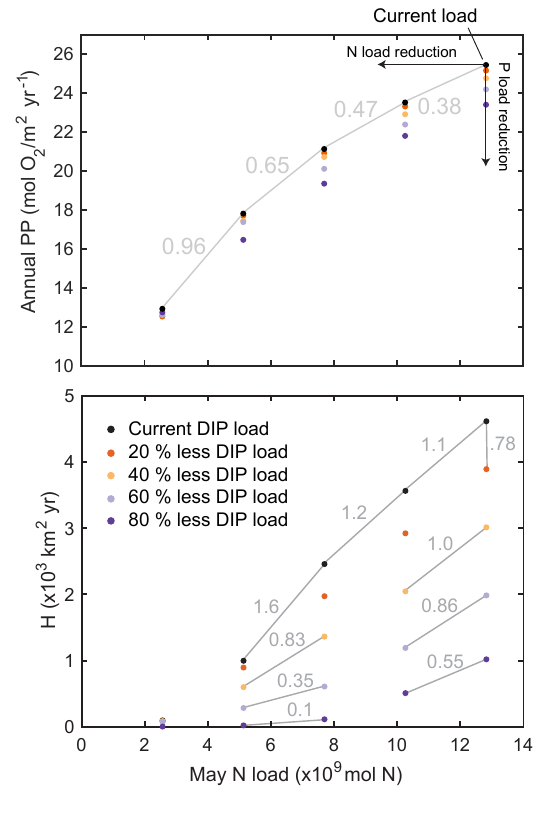
Figure 4. Shelf-averaged annual primary production (PP) and an- nually integrated hypoxic area H for 2009 plotted over May N loads for 20, 40, 60 and 80% reductions in TN and DIP loads. Gray lines and numbers indicate sensitivity to load reductions ( S ) as defined in the